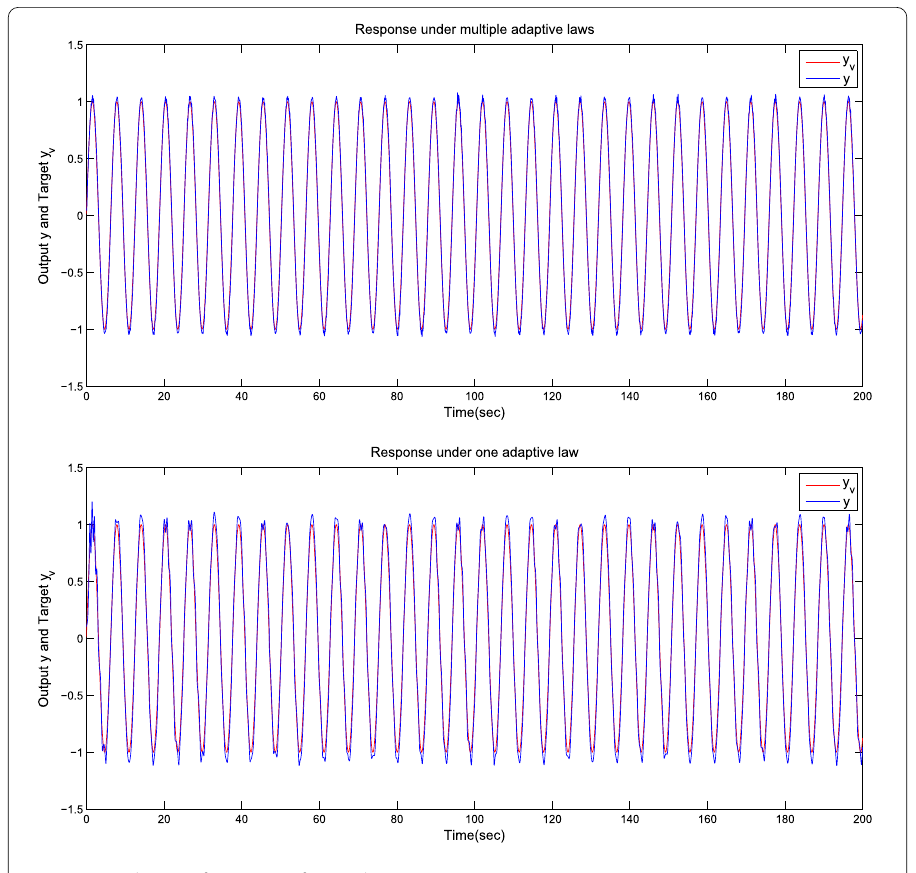
Figure 1 Tracking performances of Example